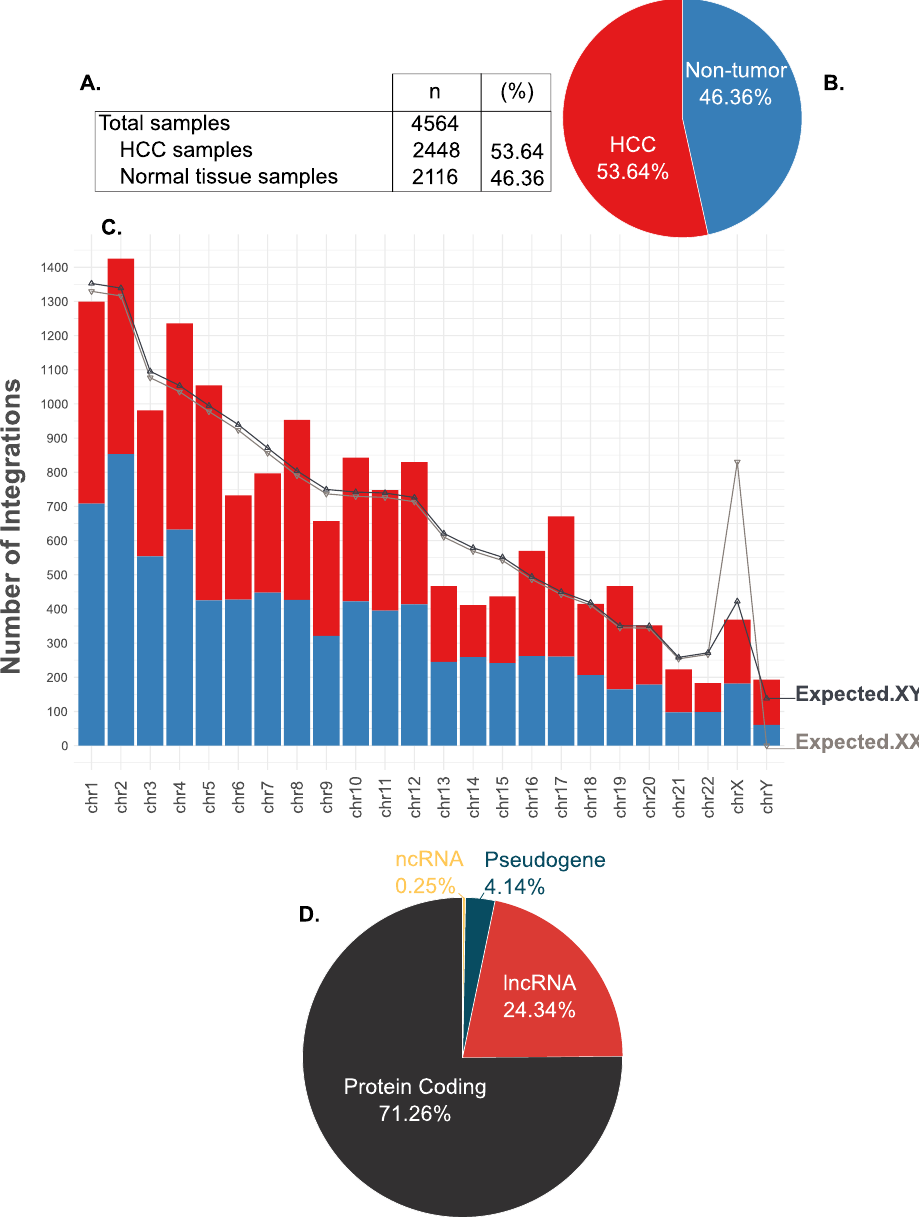
Figure 2. Graphical representation of the characteristics of the dataset used in the present study, as well as the findings obtained from the annotation of the HBV integration sites. ( A , B ) The total samples from which the HBV integrations are analyzed in the present study were obtained from previously published research papers and correspond to 2448 (53.64% of the total samples) HCC samples and 2116 (46.36% of the total samples) non-tumor tissue samples (total number of samples = 4564). ( C ) The distribution of HBV integrations in the human chromosomes (chr1–22, chrX, chrY) are depicted as bar charts. Moreover, the distribution of the HBV integrations in HCC and non-tumor samples are also depicted in the stacked bar charts, in red and blue, respectively. The expected values used in the binomial test, in which it was assumed that HBV integration is a random event and that the genomic locus of the integration depends on the size of each chromosome, are presented as lines with gray color and the ( (cid:53) ) symbol for the 46XX subjects and black color and the ( (cid:52) ) symbol for the 46XY subjects. ( D ) Representation of the biotypes of the genes that are being disrupted from HBV integration. From the 5053 disrupted, transcribed genomic loci, 3601 (71.26%) are protein-coding genes, 1230 (24.34%) are long non-coding RNAs (lncRNA), 209 (4.14%) are pseudogenes, and 13 (0.25%) are non-coding RNAs